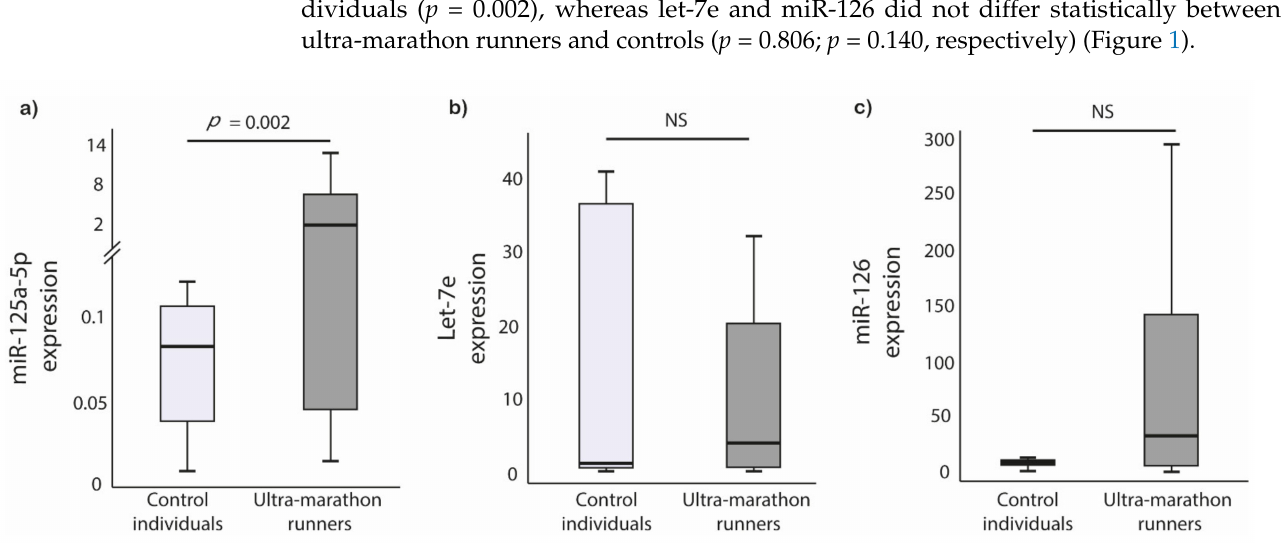
Figure 1. miRNAs relative expression difference between the groups. ( a ) miR-125a-5p; ( b ) Let-7e; ( c )